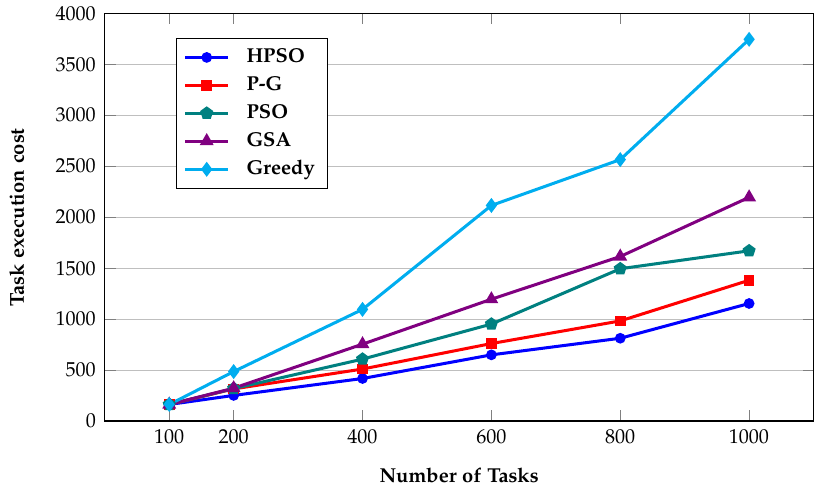
Figure 9. Consumption comparison